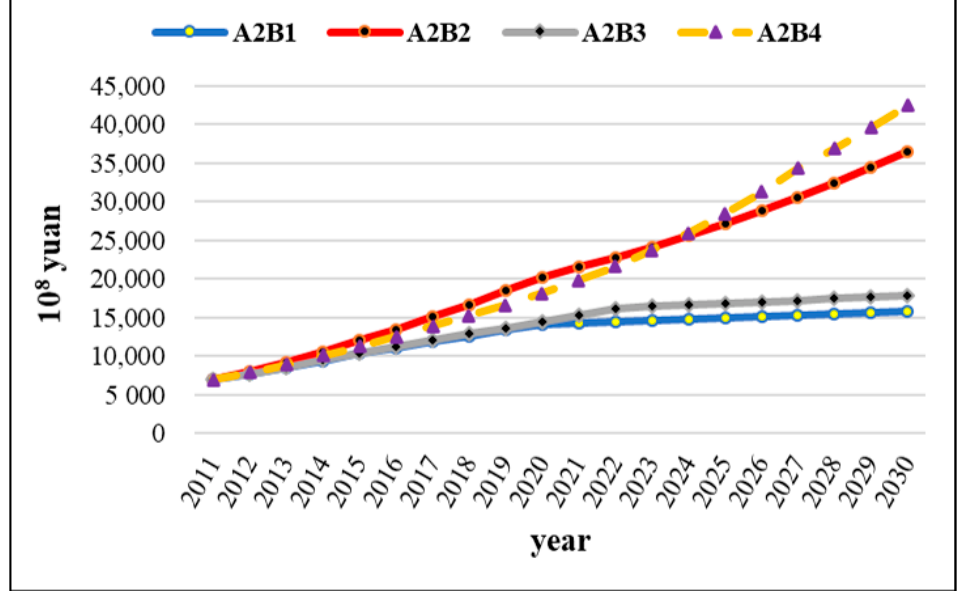
Figure 10. Evolution trend of total social and economic output value of the same water diversion quantity from transboundary river basins under 4 socio-economic development